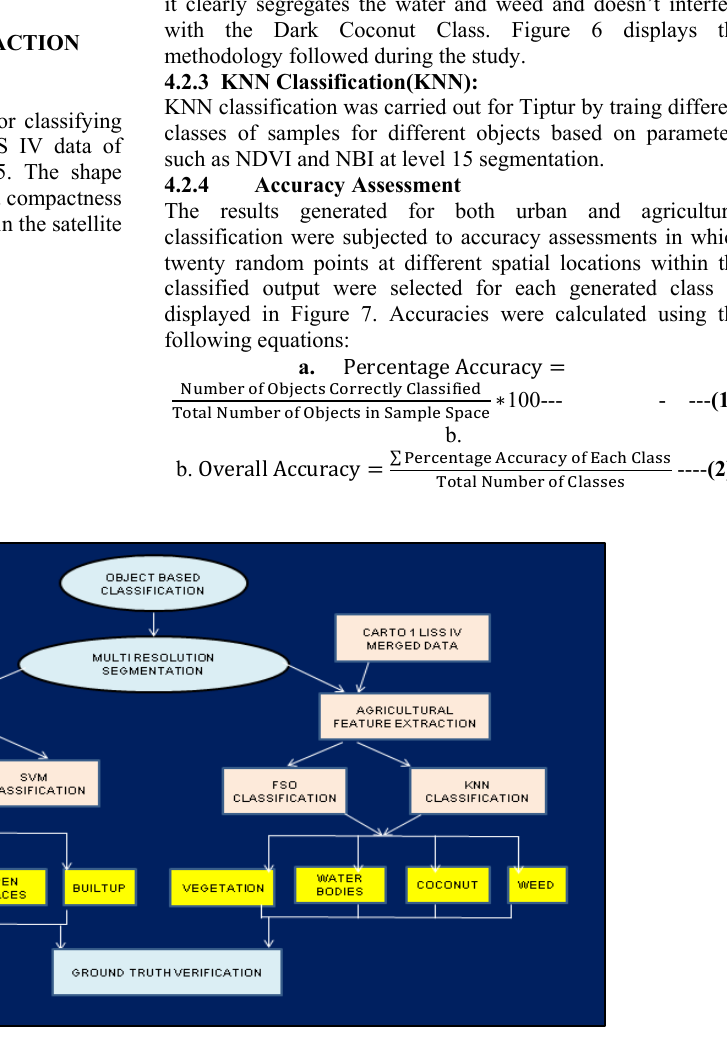
Figure 6: Methodology